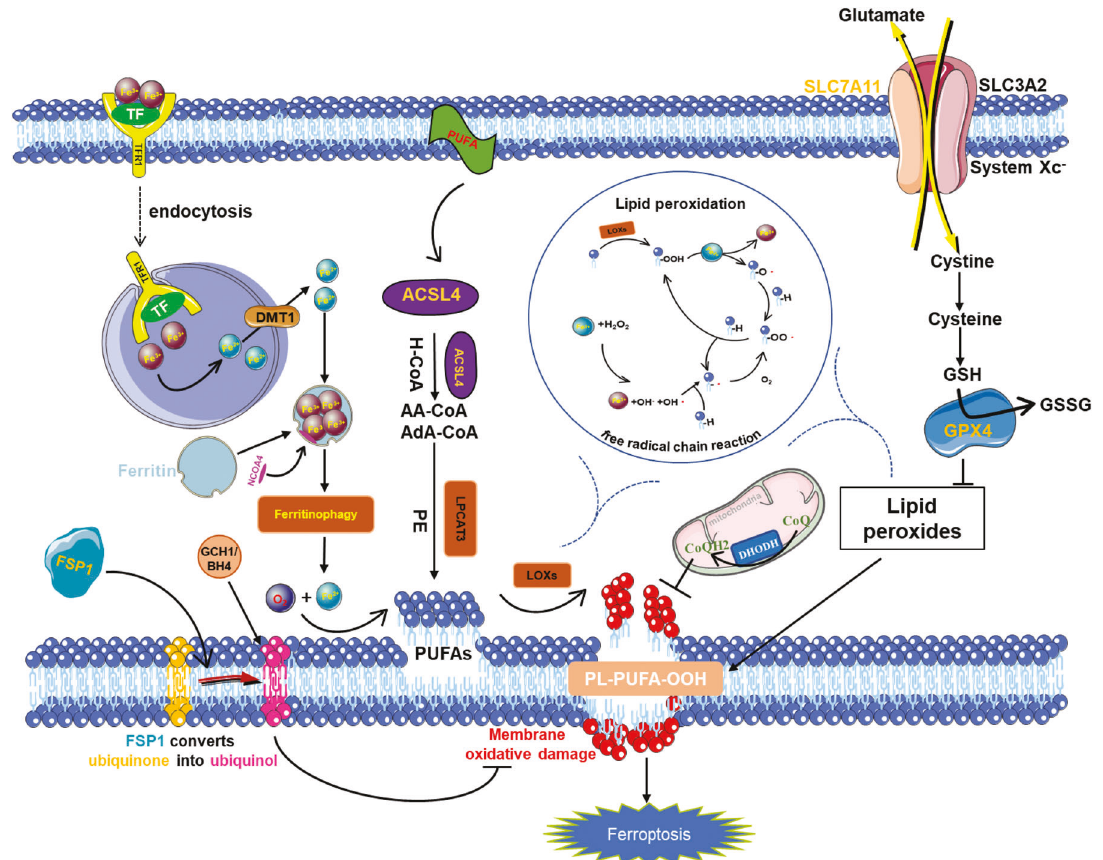
Fig. 2 Core molecular machinery and regulatory pathways of ferroptosis. System X C - obtains cystine from the extracellular environment. The cystine introduced into the cells is converted into cysteine in the cytoplasm through a reduction reaction that consumes NADPH; cysteine is then used for the biosynthesis of glutathione, Glutathione peroxidase 4 (GPX4) can catalyze reduced glutathione (GSH) to oxidized form (GSSG), at the same time, the peroxidized polyunsaturated fatty acids are reduced to protect the phospholipid bilayer in the cell from oxidative damage and inhibit ferroptosis; while the long-chain acyl-CoA synthase 4 (ACSL4) can reduce arachidonic acid and adrenal acid. Polyunsaturated fatty acids (PUFA) are activated to arachidonic CoA and adrenal CoA, which are more likely oxidized to form lipid peroxides and induce ferroptosis; membrane transferrin receptor 1 (transferrin receptor 1, TFR1) can transport trivalent iron ions into the cell, and under the action of divalent metal transporter1 (DMT1), it can convert Fe 3 + to Fe 2 + , and excess iron is stored in ferritin. Nuclear receptor coativator 4 (NCOA4) mediates the degradation of ferritin in autophagosomes, resulting in the release of ferritin-bound iron as free Fe 2 + (ferritinophagy), promoting ferroptosis; FSP1 converts ubiquinone to ubiquinol, alleviating persistent oxidative damage to cell membranes and inhibiting